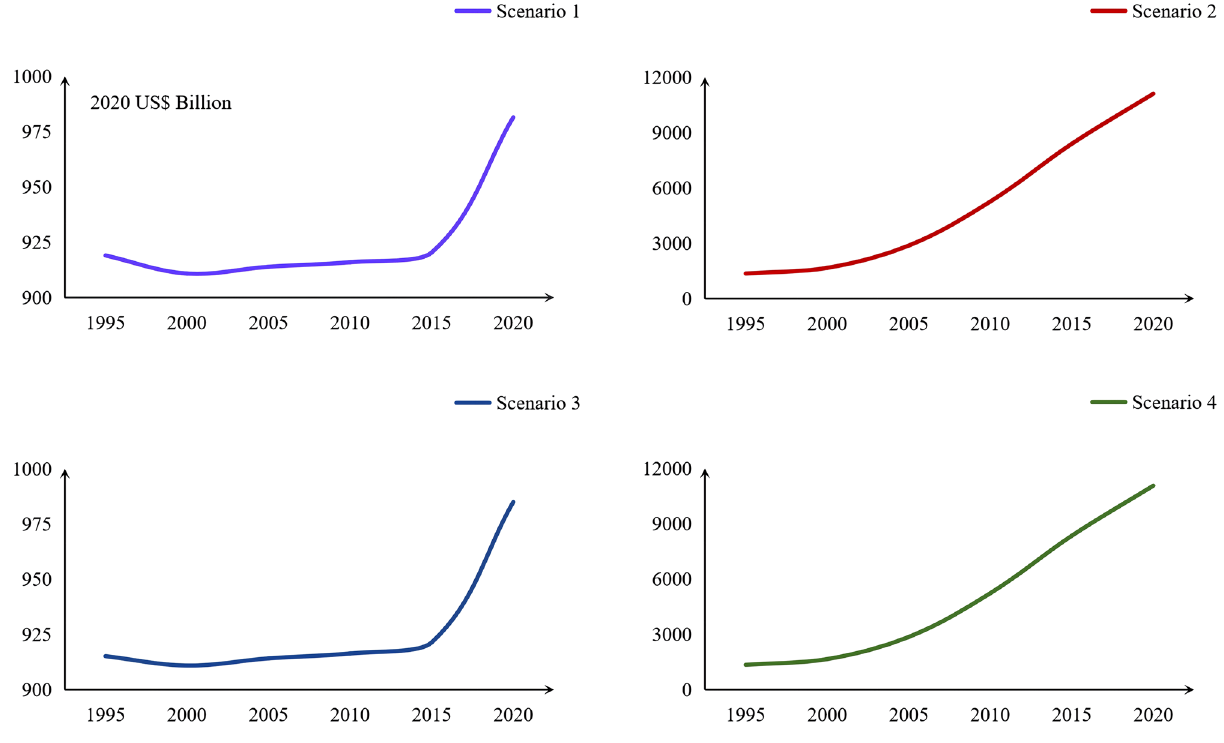
Figure 5. The respective curves of ESSVs under scenario 1–4 (unit: 2020 US$